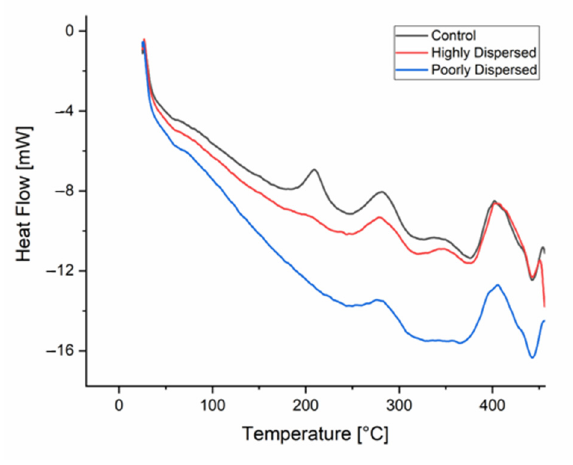
Figure 11. DSC curves of control and highly and poorly dispersed GO nanocomposites.